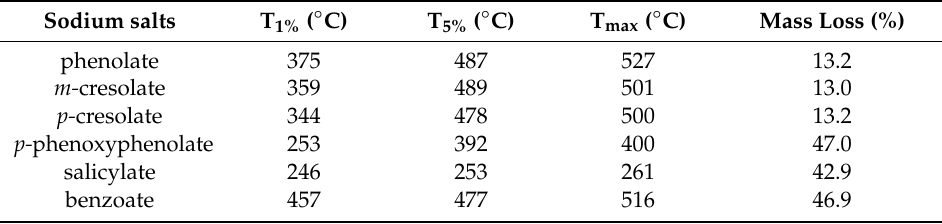
Figure 1. The thermogravemtric analyses of sodium phenolates under N 2 . Table 1. TGA data of sodium salts.